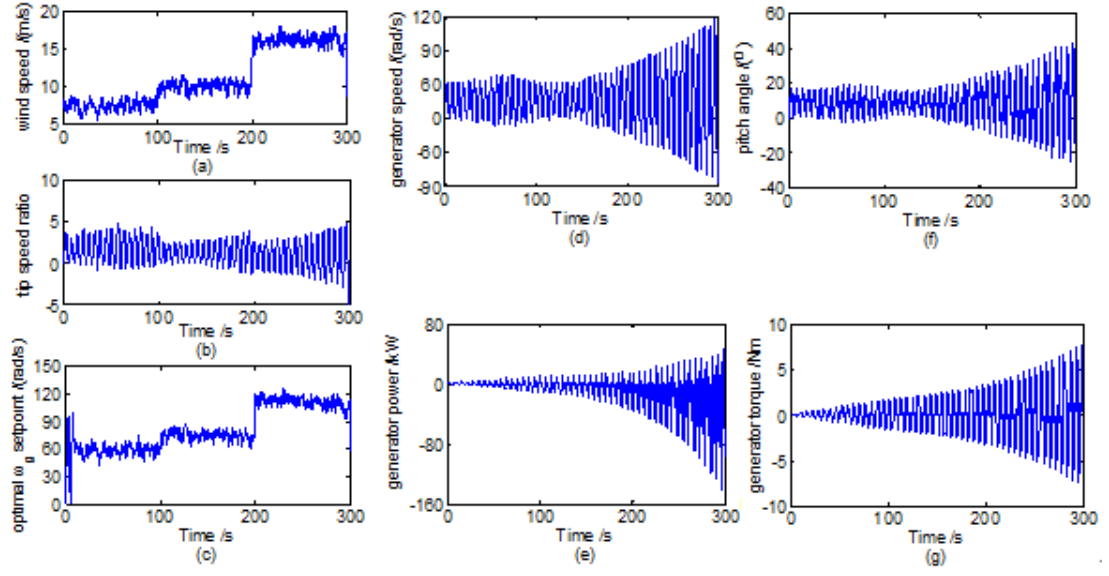
Figure 8. Sensors fault of WECS without fault tolerant control: ( a ) wind speed (m/s); ( b ) tip speed ratio; ( c ) optimal (cid:2033) setpiont (rad/s); ( d ) generator speed (rad/s); ( e ) generator (cid:3034) power (KW); ( f ) pitch angle (°); ( g ) generator torque (Nm).